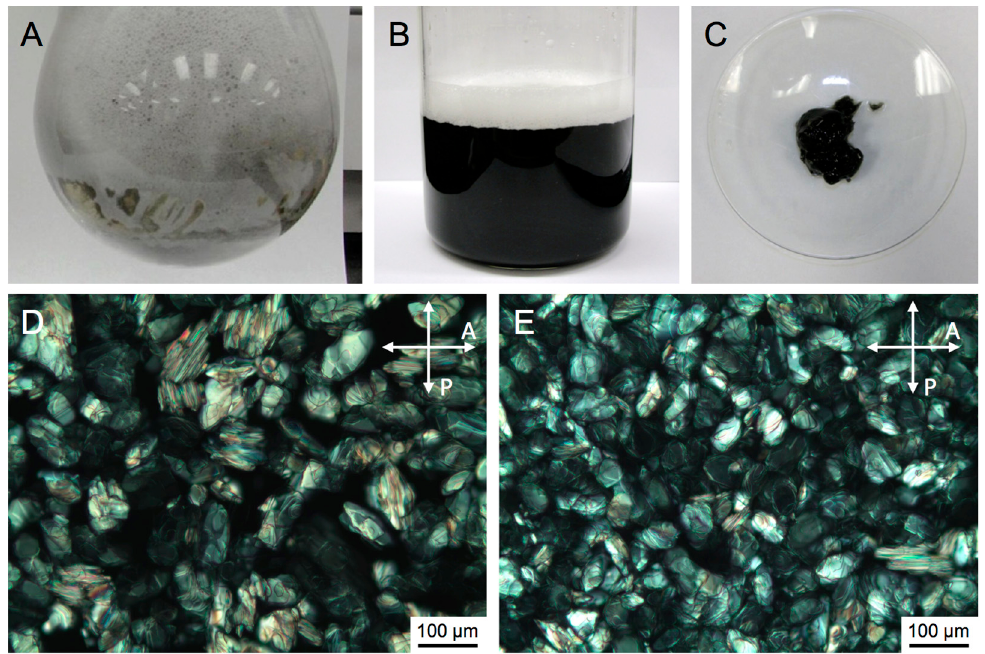
Figure 2. ( A ) Photograph showing the froth formation during after NaBH 4 addition; ( B ) Photograph showing the diluted froth solution from which as-synthesized nanostructures were isolated by magnetic separation and washing (see experimental section). For the complete experimental setup see photographs in the Supplementary Information; ( C ) Photograph showing the gel fraction that has undergone separate magnetic separation and washing; ( D , E ) Polarized light optical photomicrographs (crossed polarizer P and analyzer A ) of the hexagonal columnar phase of one of the used surfactants (here CTAB) in water: ( D ) prior to the addition of the Fe(III)-precursor and ( E ) from a small sample taken during the reaction (The fact that no difference could be detected in the polarized optical microscopy (POM) textures prior to and after addition of the reducing agent indicated the persistence of the Col hI phase as the reaction proceeded).